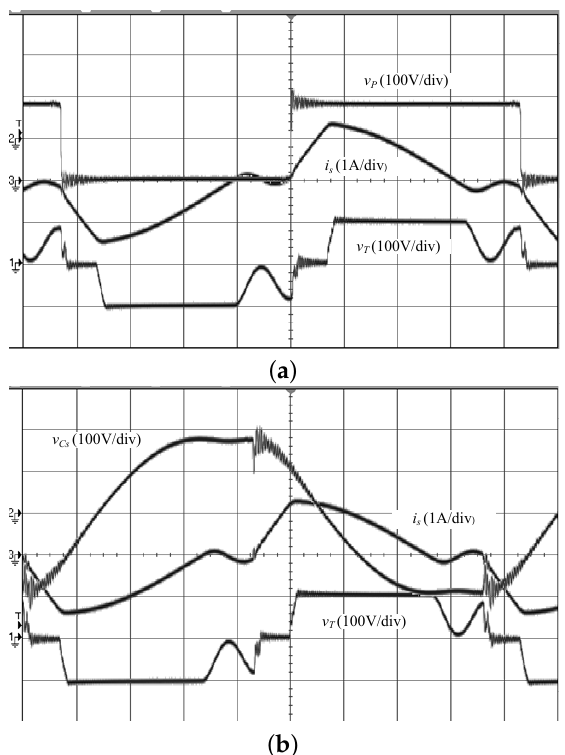
Figure 16. Experimental plot at: d > 1; V in = 80 V; V o = 100 V; P o = 45 W, DCM operation. ( a ) the HF inverter output voltage v p , the resonant current i s and the transformer voltage v T ; ( b ) the resonant capacitor voltage v p , the resonant current i s and the transformer voltage v T .